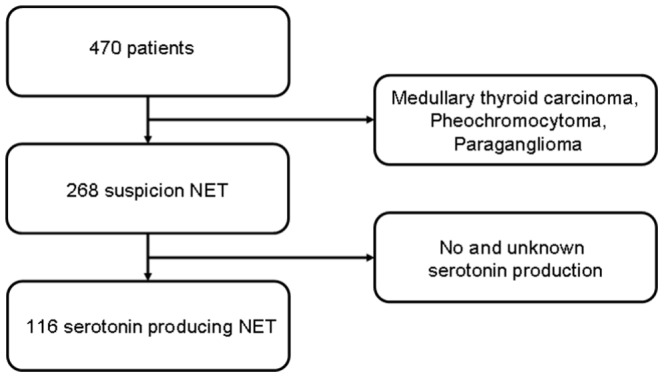
CONSORT diagram.